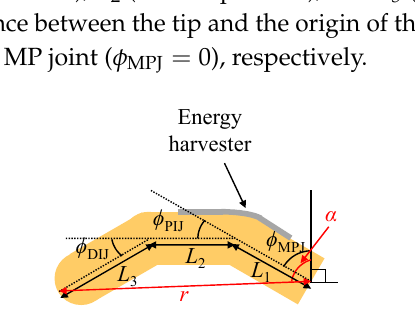
Figure 1. Schematic of parallel joints on